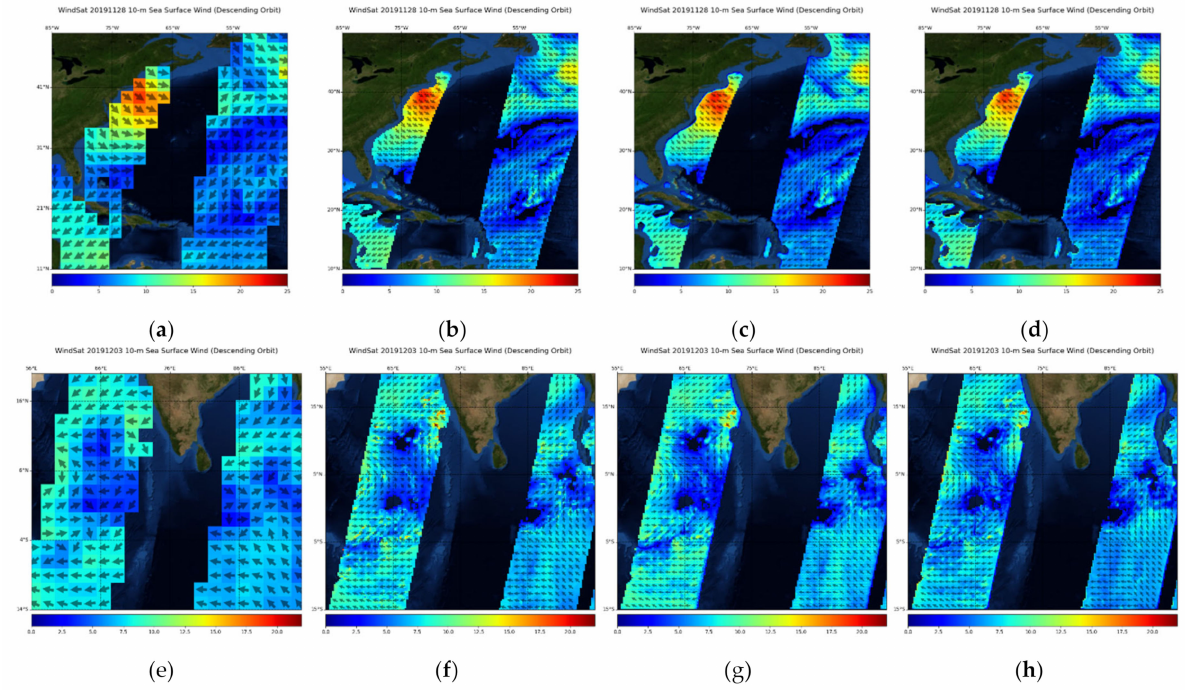
Figure 10. The visualization of sea surface wind vector: ( a – d ) The SSW at 2 ◦ (the bicubic down- sampling 8 × ), 0.25 ◦ (the original data), 0.03125 ◦ (downscaling 8 × ), 0.015625 ◦ (downscaling 16 × ) in Region 1, taking 28 November 2019, as an example; ( e – h ) The SSW at 2 ◦ (the bicubic downsampling 8 × ), 0.25 ◦ (the original data), 0.03125 ◦ (the downscaling 8 × ), 0.015625 ◦ (downscaling 16 × ) in Region 2, taking 3 December 2019, as an